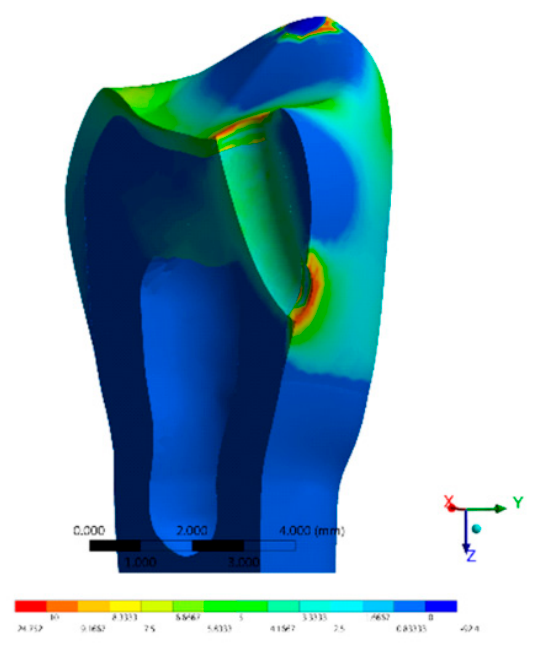
Figure 8. FEA Maximum Principal Stress results in the tunnel design with bulk-fill flowable resin. The stress peaks were recorded in two different moments; first, only the polymeriza- tion shrinkage stress effect was present as resultant from the resinous material applied to fill the cavity (Table 3). In the second moment, the resultant stress was calculated after the loads vertically applied on the cusps, simultaneously in combination with shrinkage effects (Table